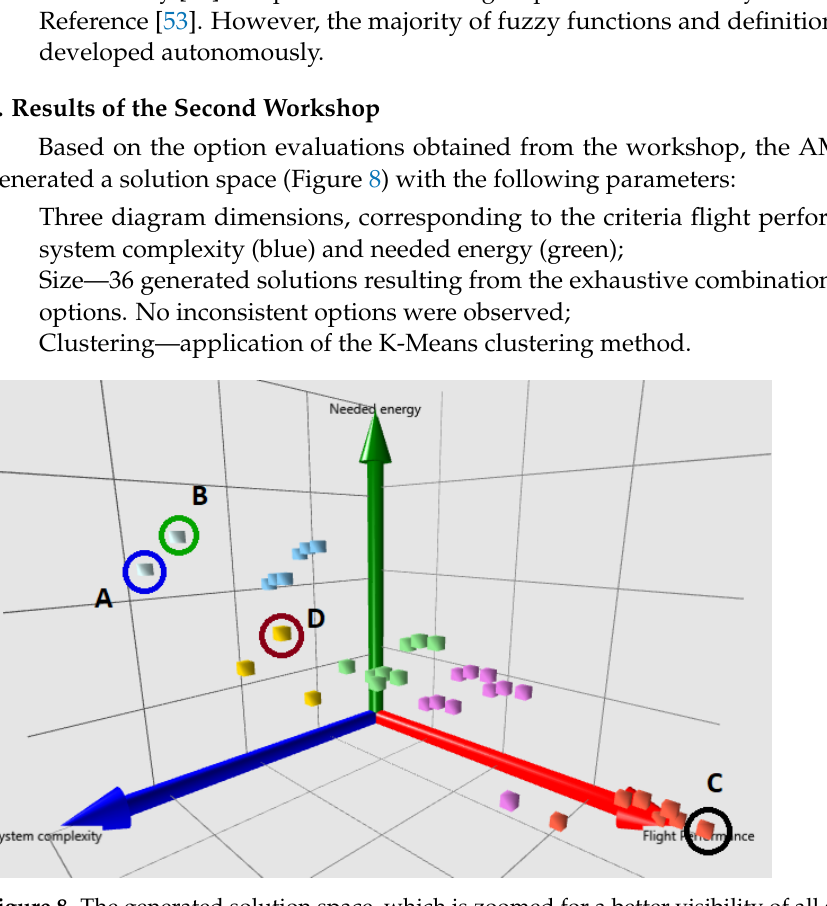
Figure 8. The generated solution space, which is zoomed for a better visibility of all solutions. The colors represent different clusters—see Table 3. The marked solutions can be interpreted as follows: A—local maximum according to system complexity; B—local maximum according to needed energy; C—local maximum according to flight performance; D—global optimum/compromise considering all